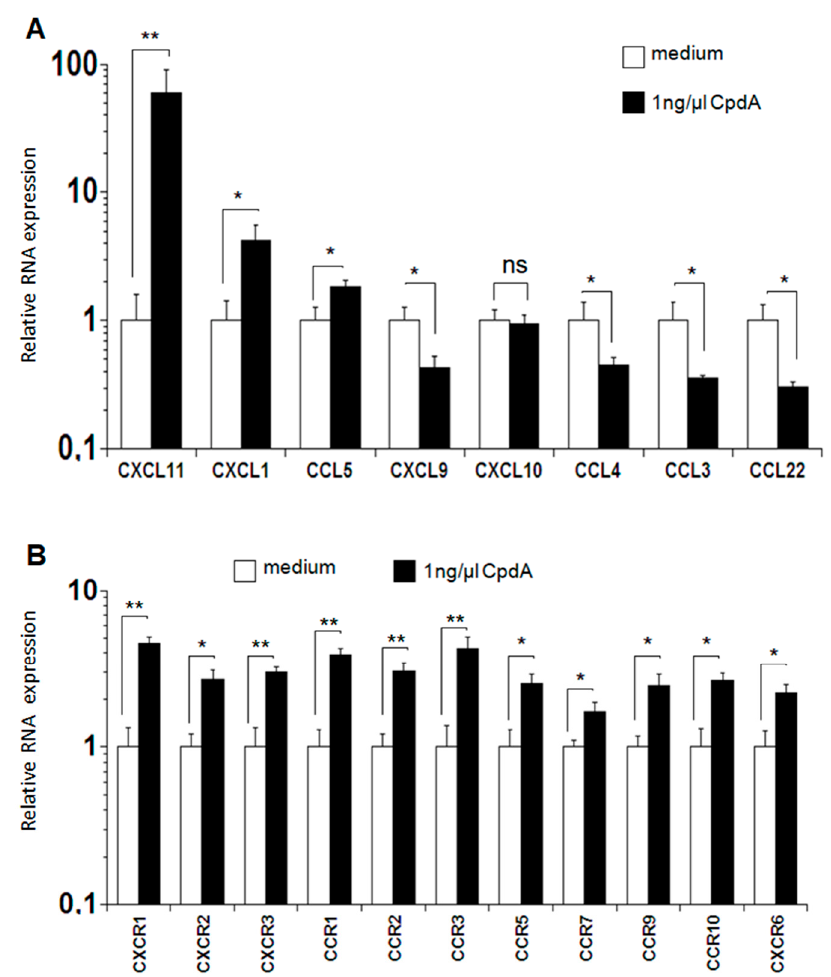
Figure 5. Expression of chemokines and chemokine receptors in cells after MLR. MLR was performed as described in the Section 4. ( A ) mRNA expression levels of chemokines and ( B ) chemokine receptors were determined in cells using real-time PCR at the end of MLR. The combined results from the two experiments are shown, and data are presented as mean ± SEM; * p < 0.05, ** p < 0.01, non-significant